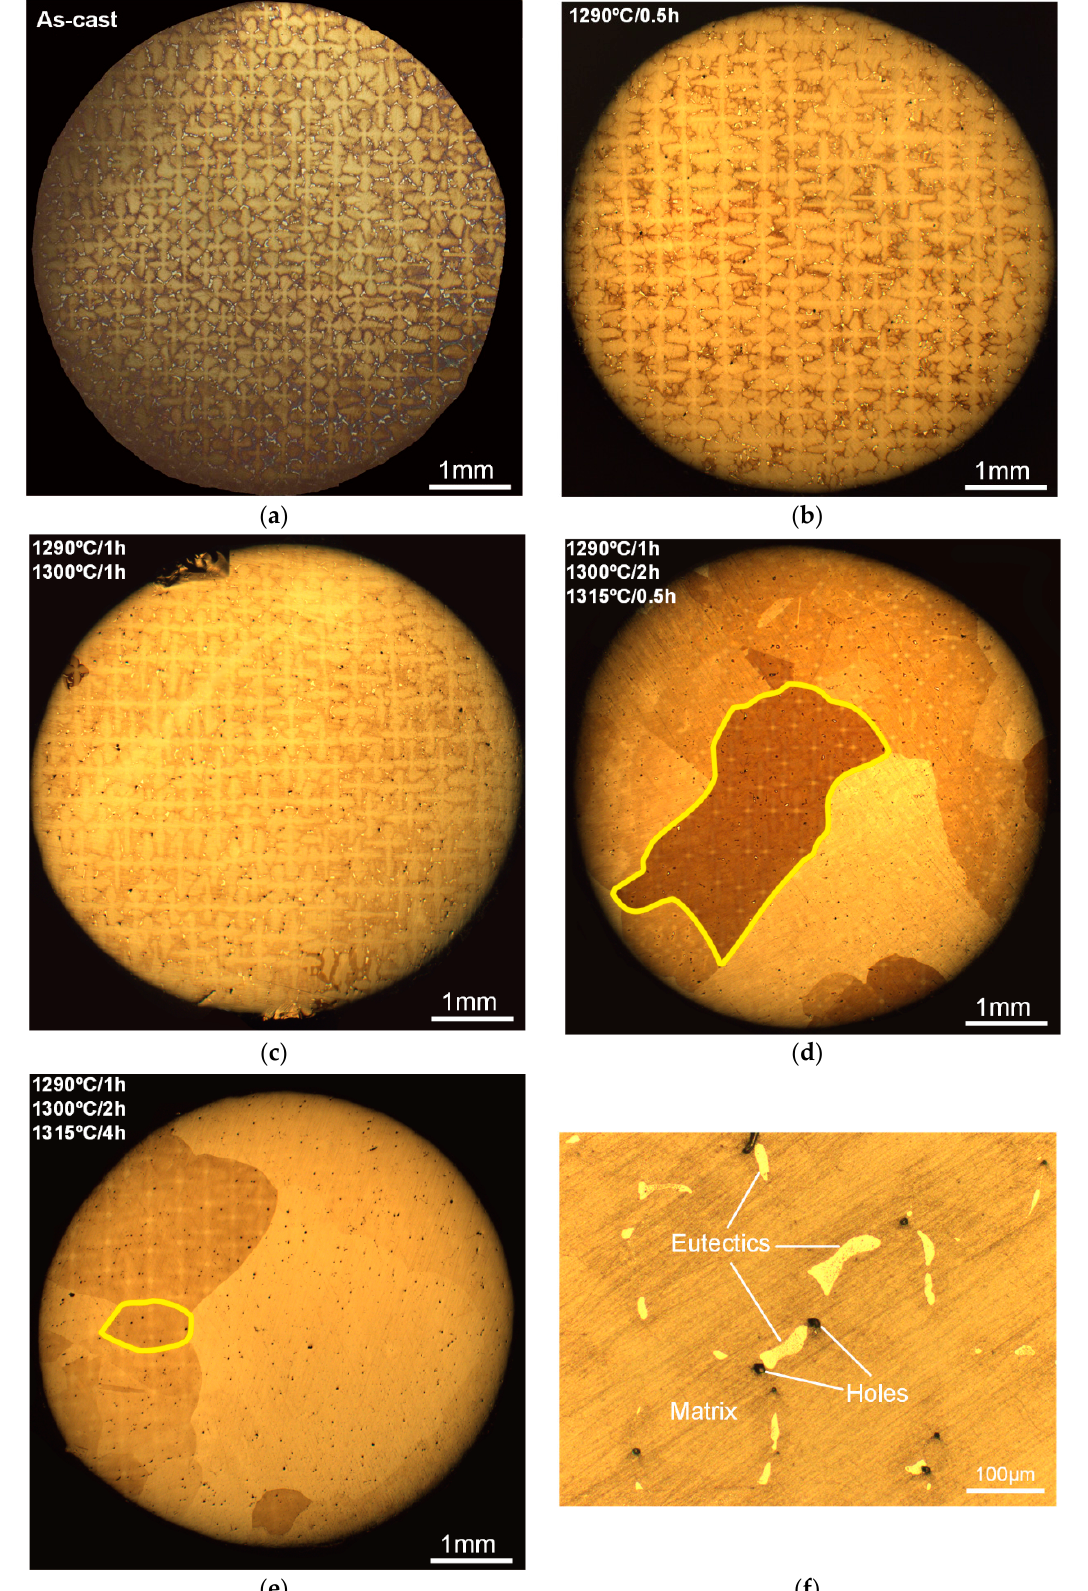
Figure 4. Microstructural evolution of S-RT during SSHT procedure. ( a ) As-cast deformed; ( b ) S-RT-2; ( c ) S-RT-3; ( d ) S-RT-4; ( e ) S-RT-5; ( f ) holes near eutectics.